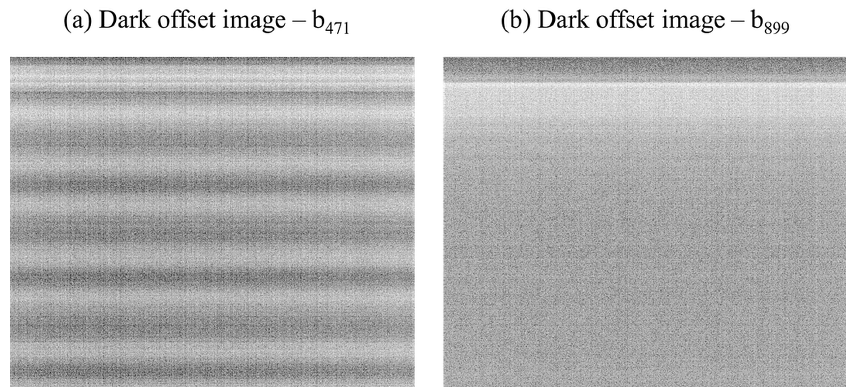
Figure 5. ( a ) Dark offset image of b 471 showing periodic noise and progressive shutter band noise; ( b ) Dark offset image of b 899 showing a global checkered pattern and progressive shutter band noise.